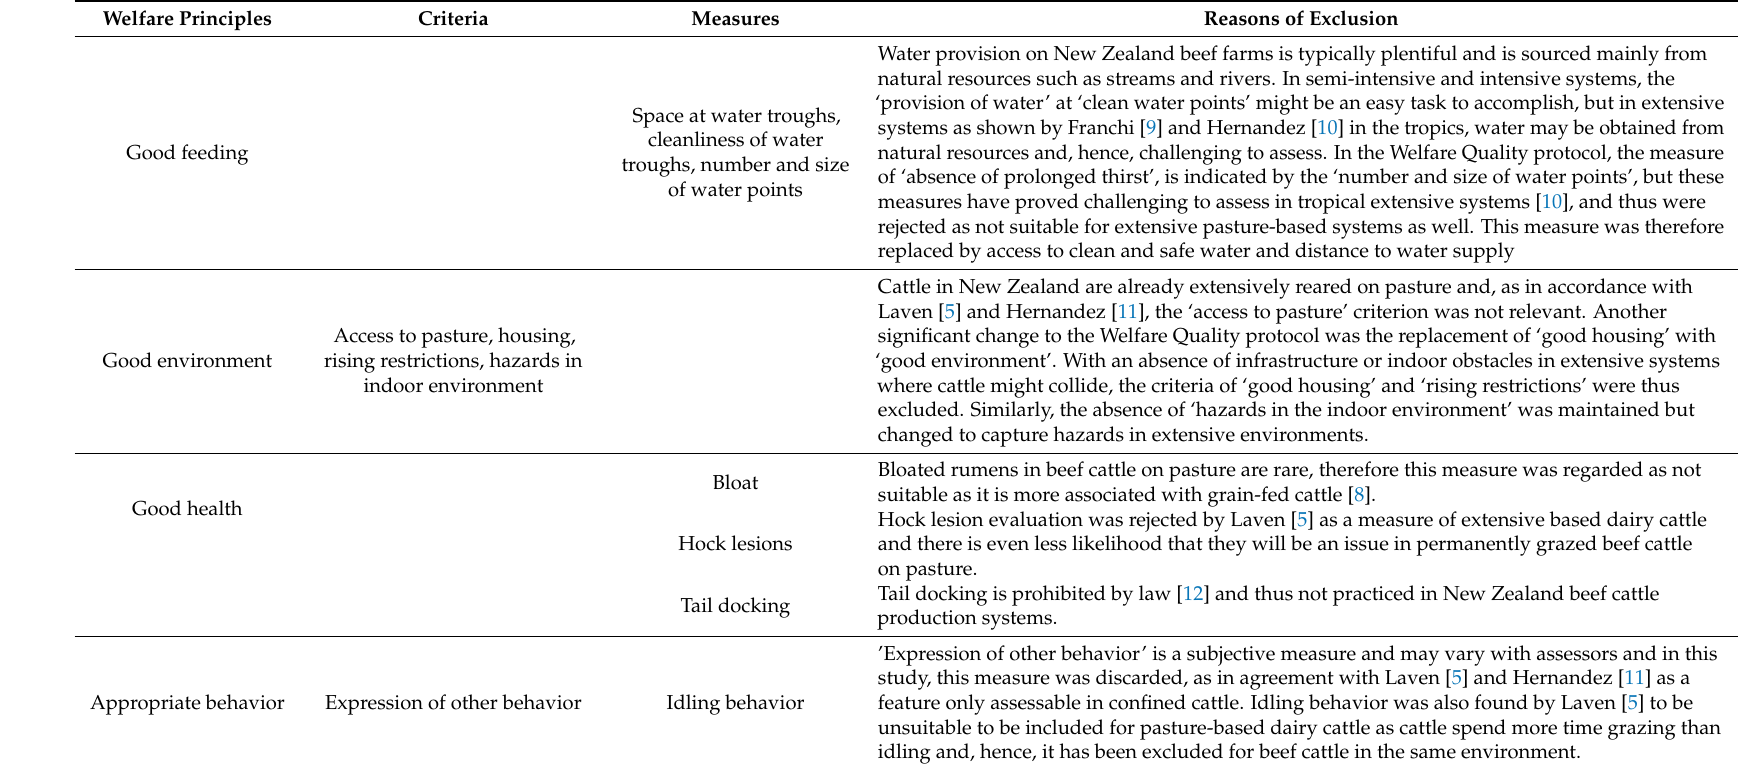
Table 1. Excluded welfare assessment criteria and measures (from Welfare Quality [6] and UC Davis [7] protocols) and reasons for exclusion as unsuitable for extensive pasture-based beef systems in New